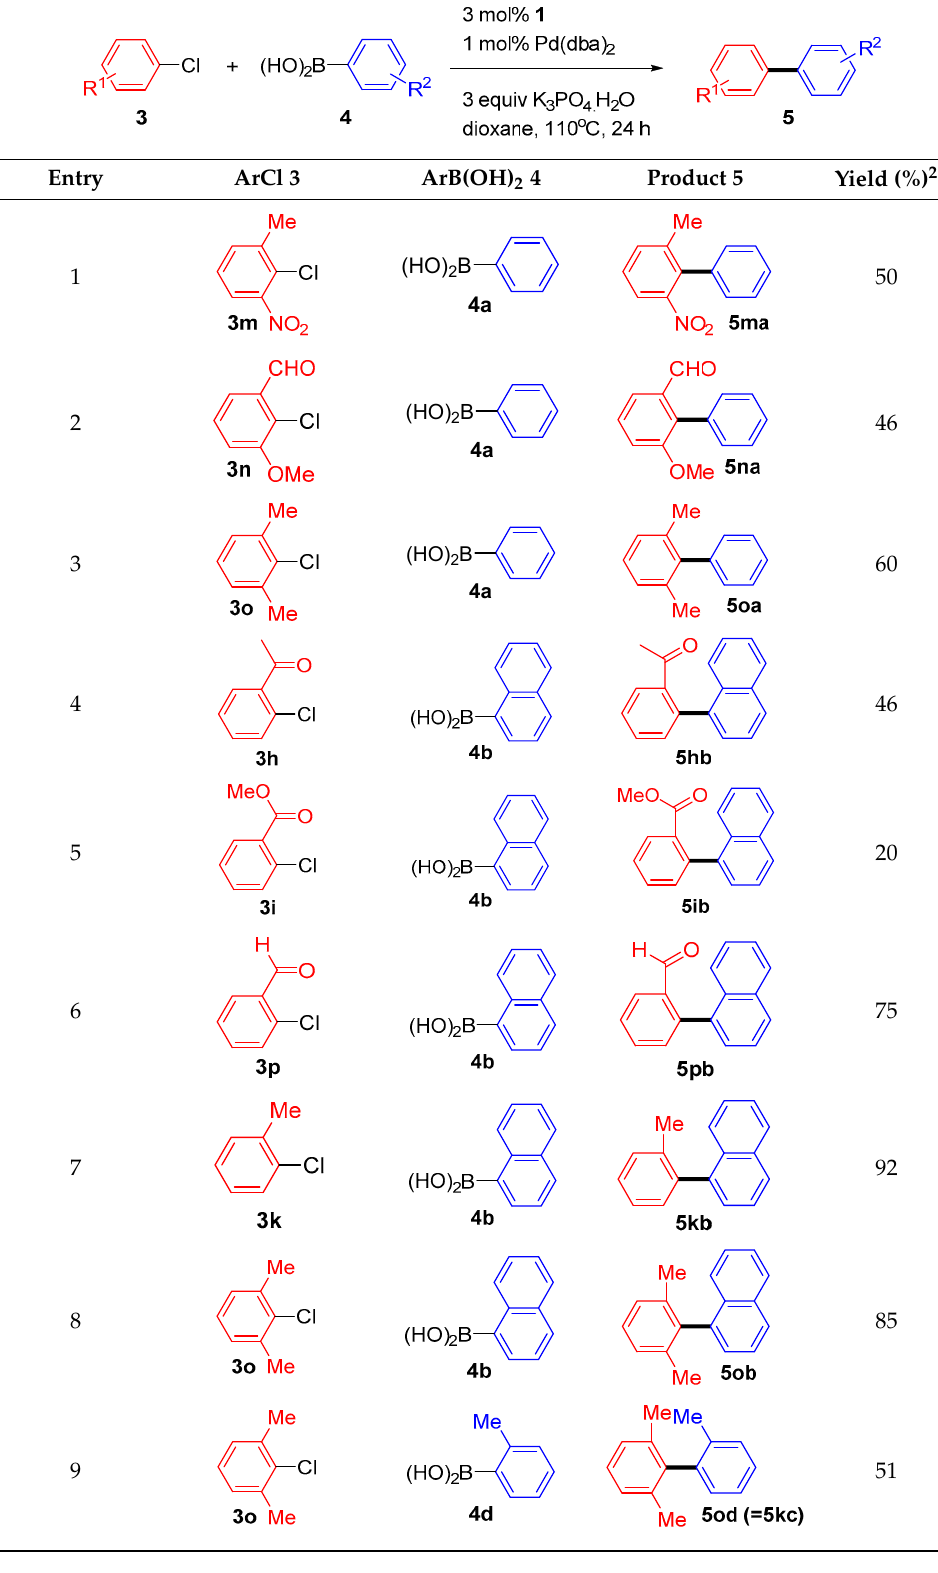
Table 3. Poly- ortho -substituted biaryl synthesis using in situ-generated catalyst. 1